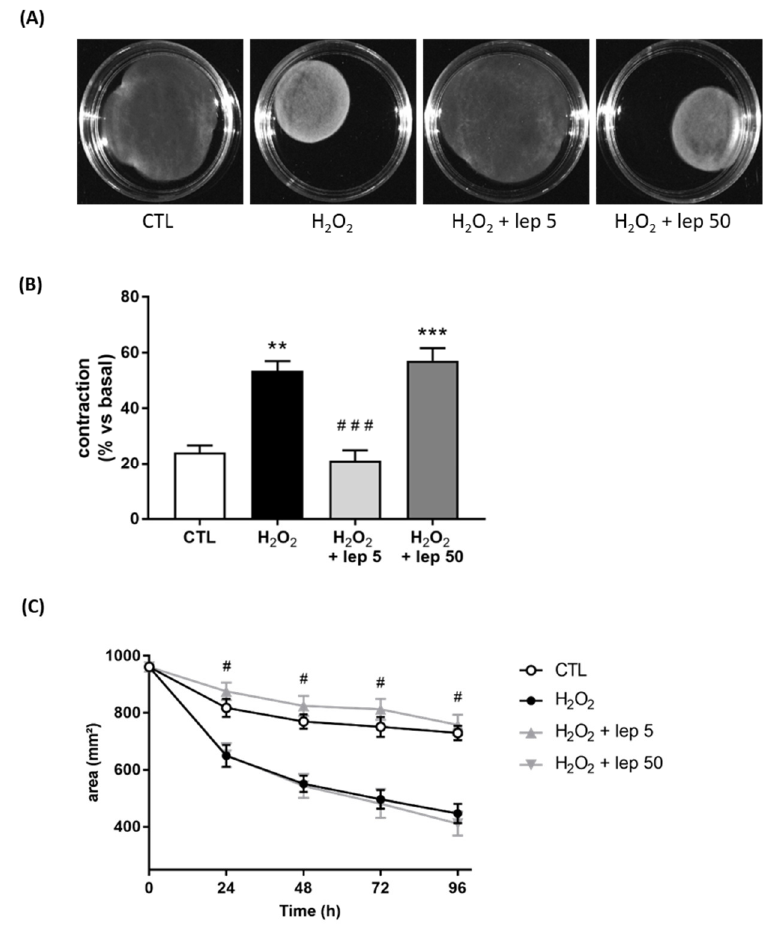
Figure 5. Effect of leptin on H 2 O 2 -induced contraction in myometrial cells. Myocytes were treated with or without H 2 O 2 and leptin at 5 or 50 ng/mL. ( A ) Images of collagen lattices in presence or absence of H 2 O 2 and leptin, for 96 h. Pictures are representative of four experiments. ( B ) Percentage contraction of collagen lattices (mean ± SEM) after 96 h of stimulation with H 2 O 2 and leptin, compared to the initial surface area, n = 4, ** p < 0.01 and *** p < 0.001 versus CTL, ### p < 0.001 versus H 2 O 2 . ( C ) Time-course variation of collagen lattices area ± SEM up to 96 h of treatment with H 2 O 2 and leptin. # p < 0.05 versus H 2 O 2 .